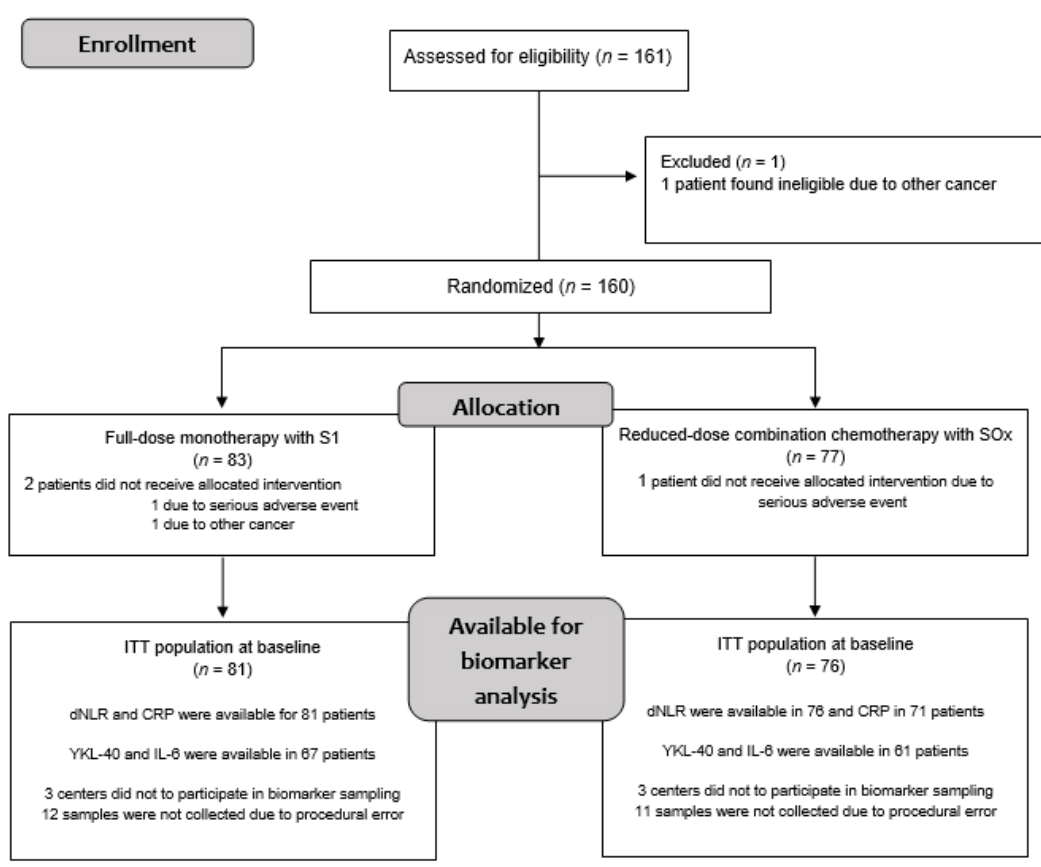
Figure 1. CONSORT 2010 diagram presenting patient flow in the NORDIC9-study. Abbreviations: ITT: intention-to-treat, dNLR: derived neutrophil-to-lymphocyte ratio, CRP: C-reactive protein. Demographic and clinical characteristics were balanced between the treatment